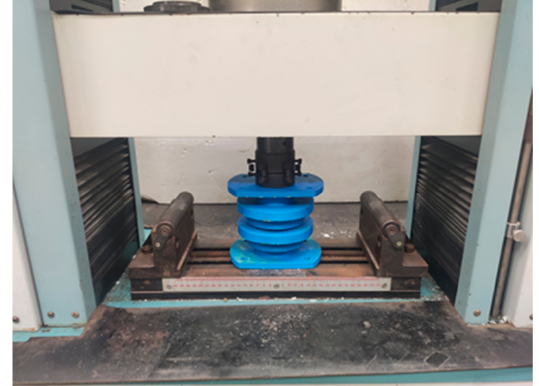
Figure 9. Installation diagram of specimen.